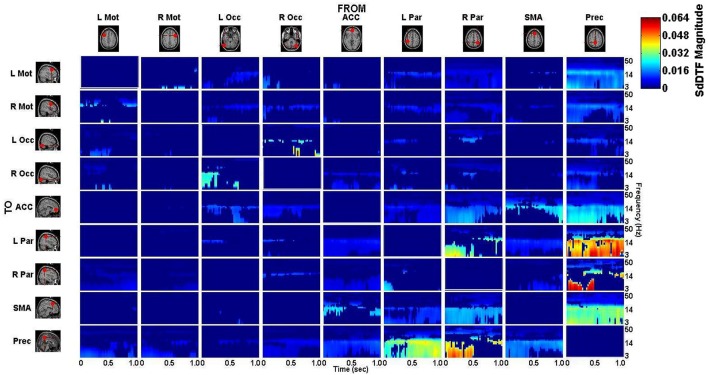
p-value thresholded spectro-temporal asymmetric cortical connectivity matrix for the lift condition. Network sources are tabulated at the columns and sinks at the rows. The dynamic causal relationship between each source and sink is expressed by the corresponding SdDTF. Non-zero connectivity is displayed only at spectro-temporal points with p < 0.05, thus only displaying statistically significant connectivity in the cortical network for the Lift condition. Note the frequency axis is plotted on a logarithmic scale to more clearly show lower frequency band connectivity, where the majority of causal flow occurs in this network.